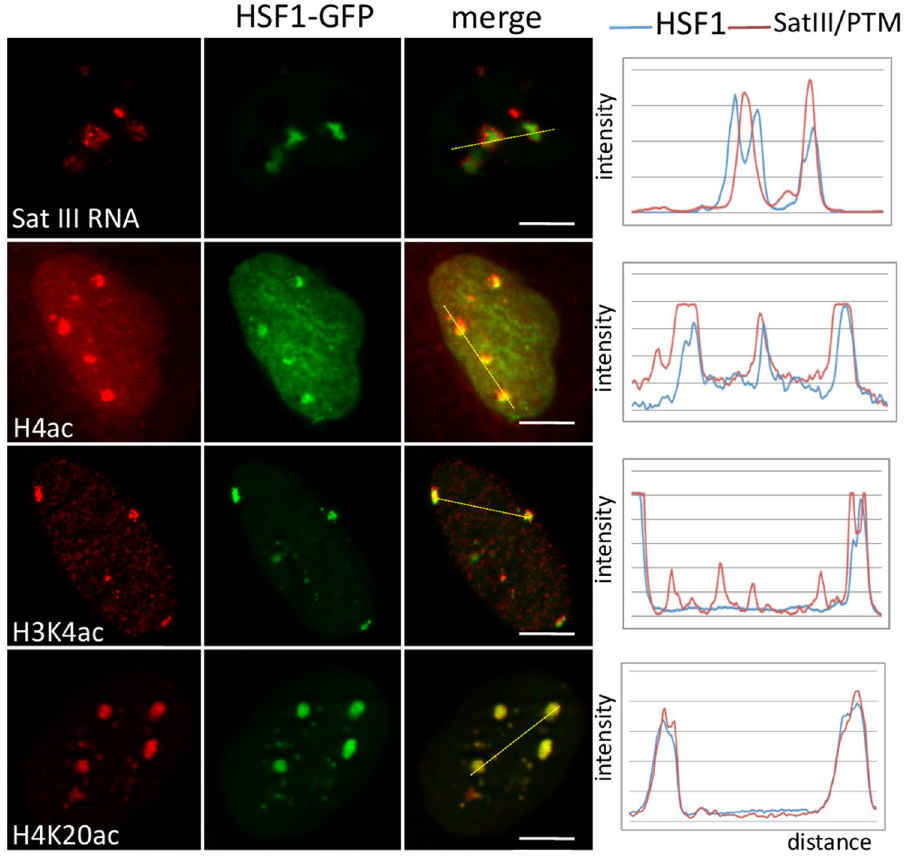
Figure 4. Overexpressed HSF1 directs chromatin acetylation at nSBs in unstressed HeLa cells. HSF1 foci were detected in cells transiently transfected with HSF1-GFP. HSF1-GFP foci correspond to regions of hyperacetylated chromatin and of sat III RNA accumulation, thus demonstrating that DNA-binding competent HSF1 directs chromatin acetylation at the 9q12 region in a stress-independent manner. Scale Bar = 5 µ